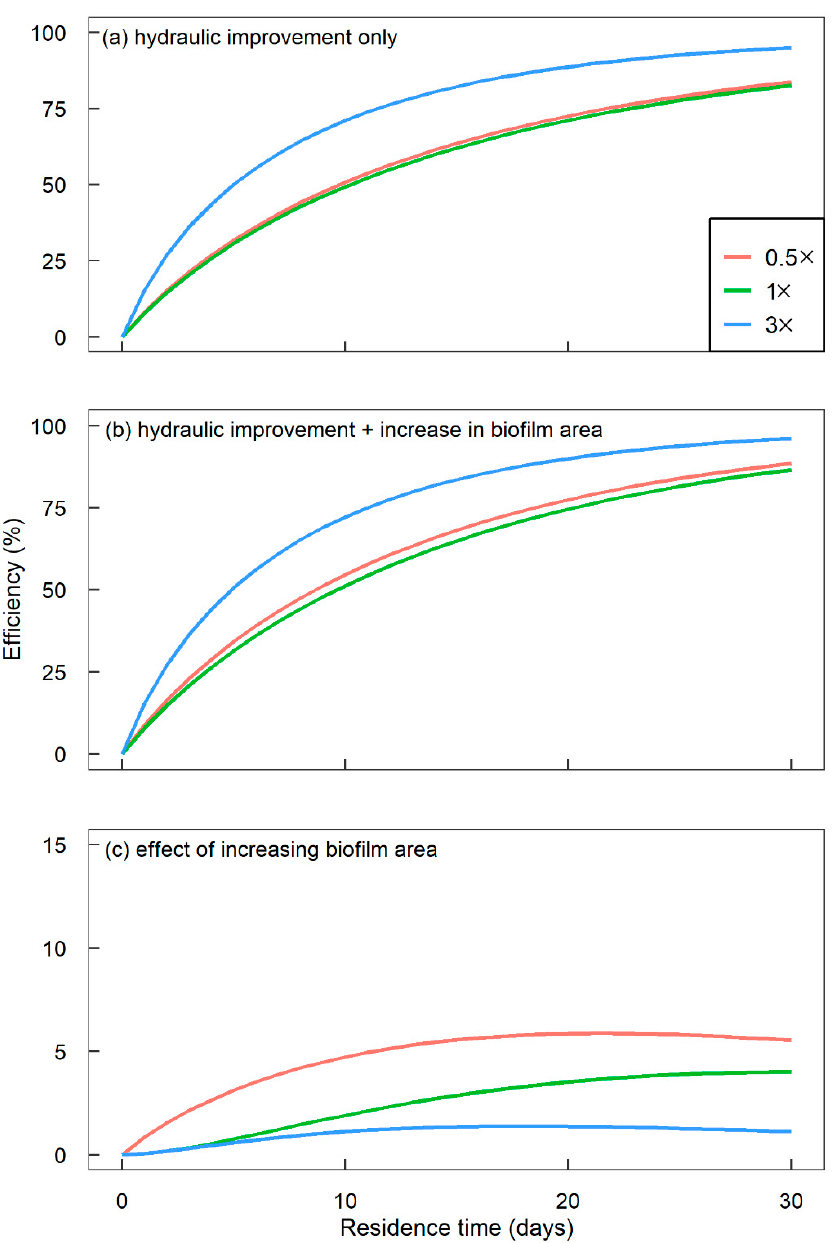
Figure 8. Comparison of biological oxygen demand (BOD) removal efficiency under three scenarios, 0.5 × (red), 1 × (green), and 3 × (blue) loading, shown as: ( a ) hydraulic improvement only, ( b ) hydraulic improvement with an increase in biofilm area, and ( c ) effect of increasing biofilm area only, calculated as the difference between scenarios shown in ( a , b ). The increase in biofilm area has a more obvious impact on ponds receiving lower organic loading.